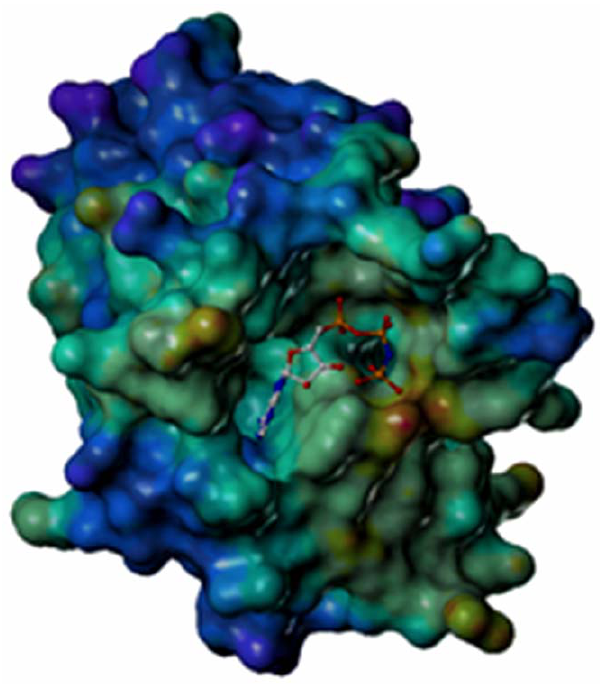
Figure 1. Shape and surface features of the ATP-binding pocket of the PhoQ HK domain. The 3D model of the PhoQ HK domain of Sf 301 shown was constructed based on the crystal structure of the PhoQ HK of E. coli , which is highly homologous to S. flexneri (more than 99.8%). The ATP binding pocket is fairly large and deep. Two cavities joined by a gorge-like channel create the whole binding pocket.